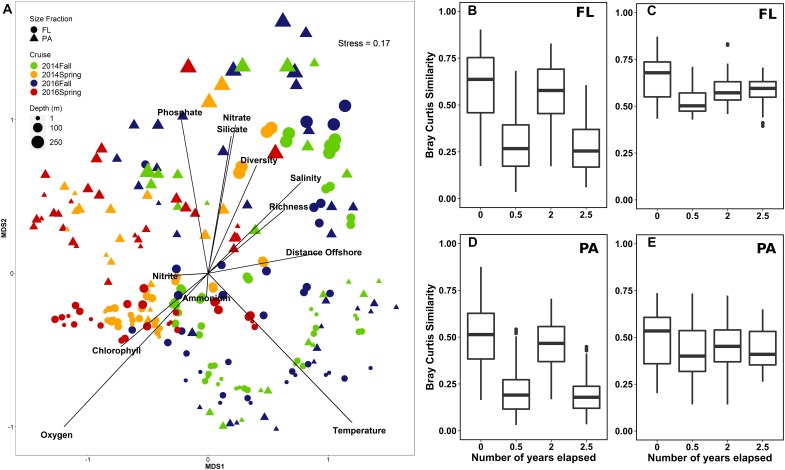
Comparison of Halifax Line (HL) spring and fall communities in 2014 and 2016 (n = 252) in the free-living (FL) and particle-attached (PA) size fractions. (A) Non-metric multidimensional scaling analysis of Hellinger transformed proportional OTU abundance data using the Bray-Curtis dissimilarity matrix. The symbols for the samples are colored based on season, their shape represents the different size fraction, and the size of the symbol indicates the sampling depth in the water column, on a continuous scale from 1-200 m. Environmental vectors were fit onto the ordination using the function envfit. Diversity refers to the Shannon diversity index. (B–E) Boxplots showing the range of pairwise comparisons of Bray-Curtis similarity between samples separated by the same number of seasons from the surface (B,D) and deep (C,E) waters.